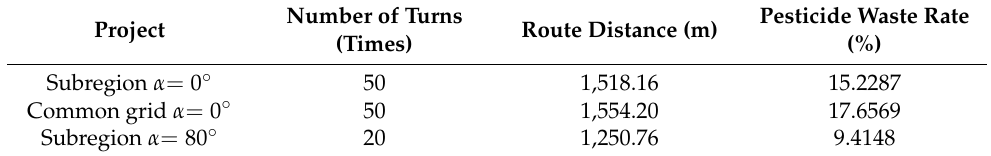
Table 2. Comparison of numerical simulation results using three different